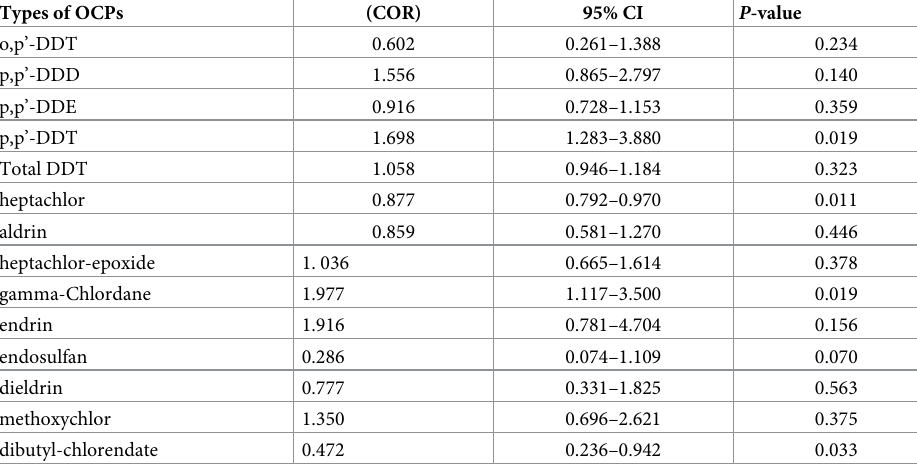
Table 4. Bivariate logistic regression results of OCPs and breast cancer association.